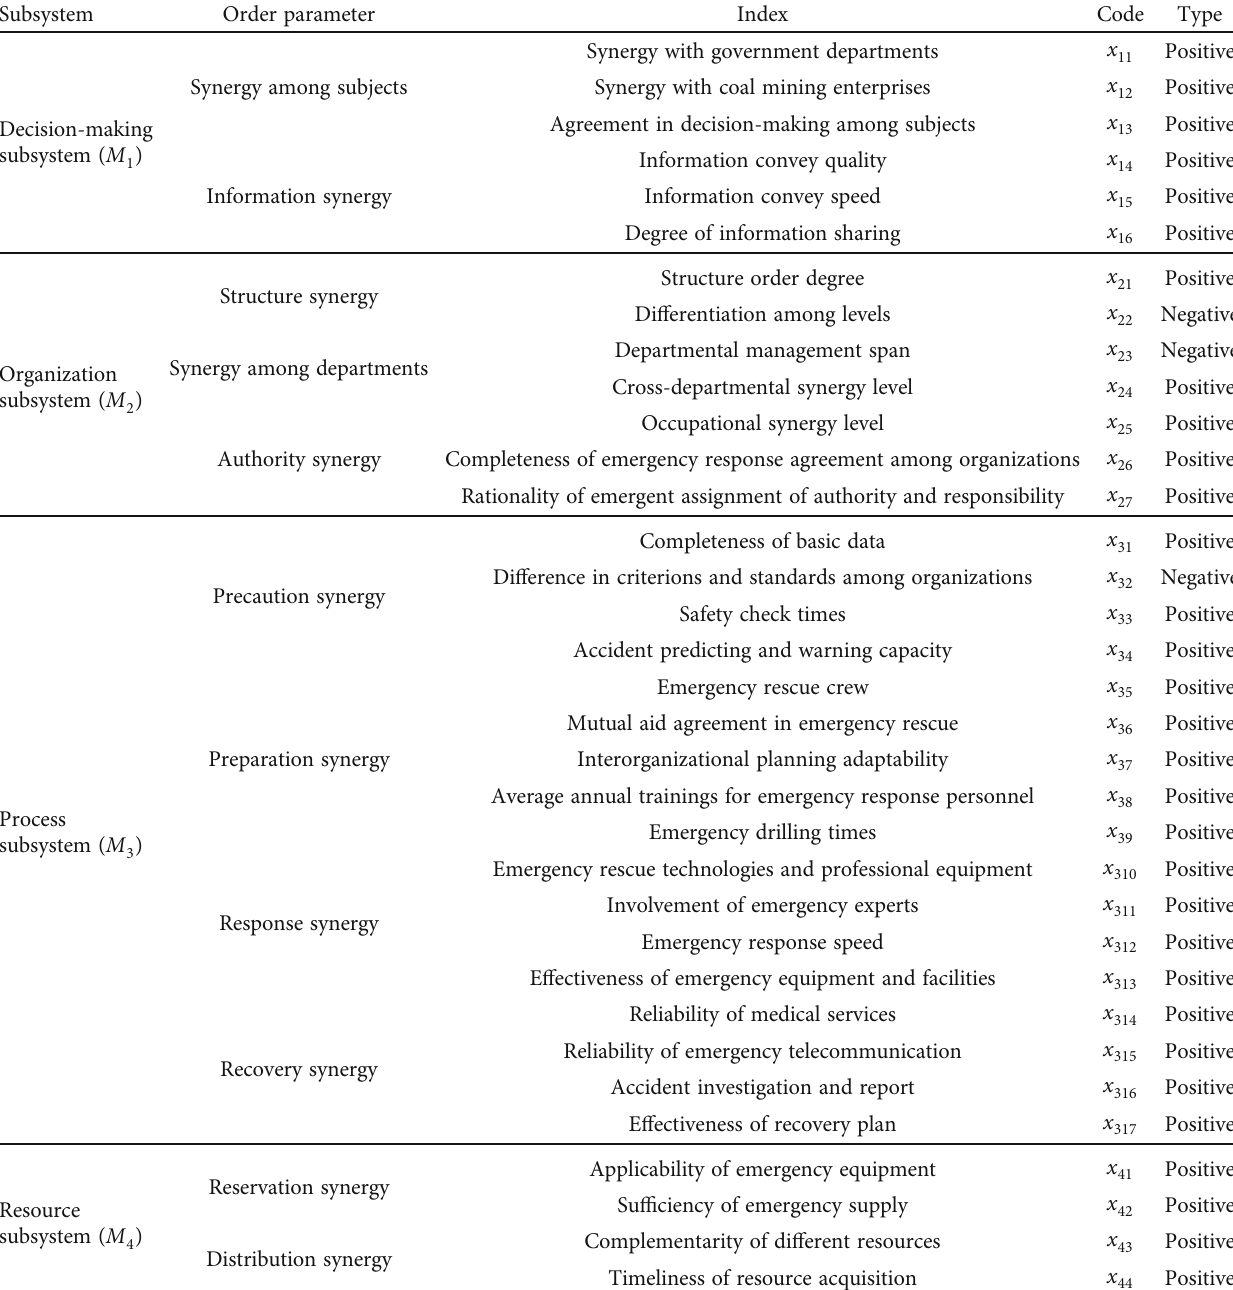
Table 2: Synergistic degree evaluation index system of the regional CME management synergy